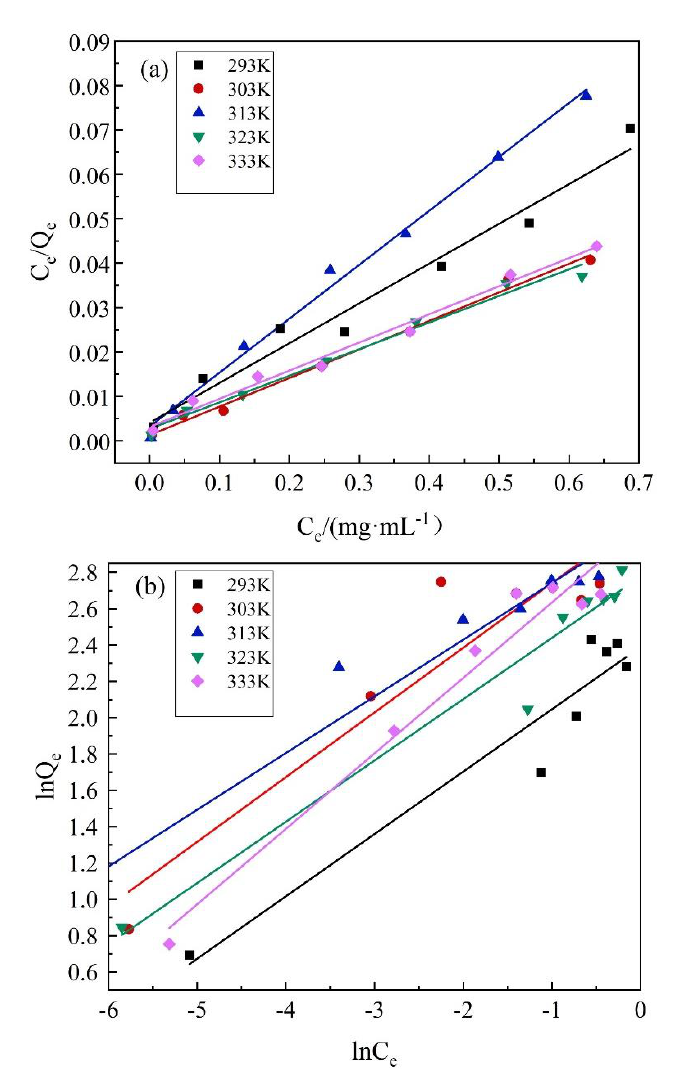
Figure 6. Adsorption isotherm. ( a ) Langmuir isotherms. ( b ) Freundlich isotherms. Table 1. Fitting parameters of the adsorption isotherm.